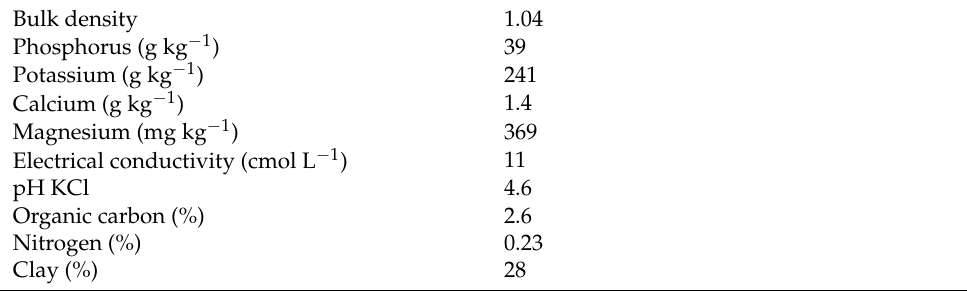
Table 1. Selected soil properties of the surface A horizon (0–0.3 m) at the field trial (Ukulinga farm of the University of KwaZulu Natal, Pietermaritzburg, South